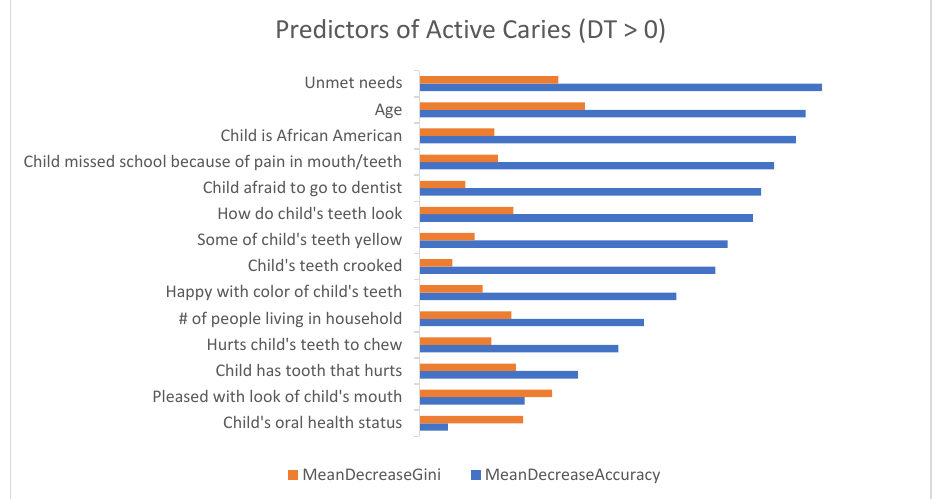
Figure 1. Demographic and oral health-related predictors of active caries (DT > 0) showing both the mean decreasing of Gini (MDG) and mean decreasing of accuracy (MDA) measures. The higher the MDG and MDA, the more important the variables. Dent. J. 2021 , 9 , x FOR PEER REVIEW